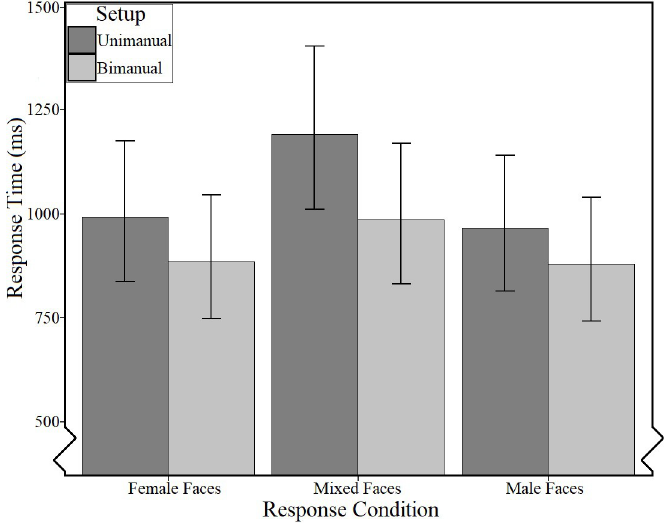
Fig 6. Estimated means [and 95% confidence intervals] for response time (ms) as a function of setup and response condition (complex task).